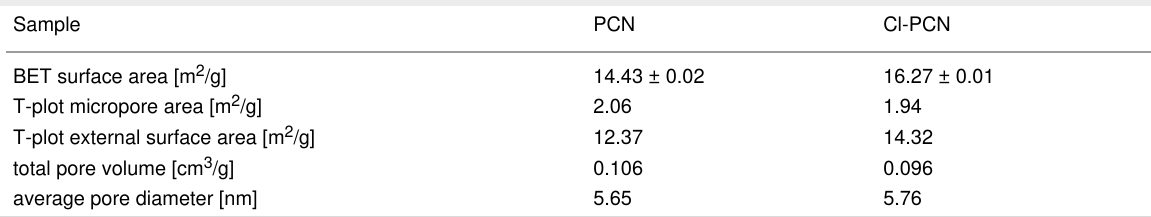
Table 3: BET surface area, T-plot analysis results for micropore area, external surface area, total pore volume, and average pore diameter of PCN and Cl-PCN. Sample